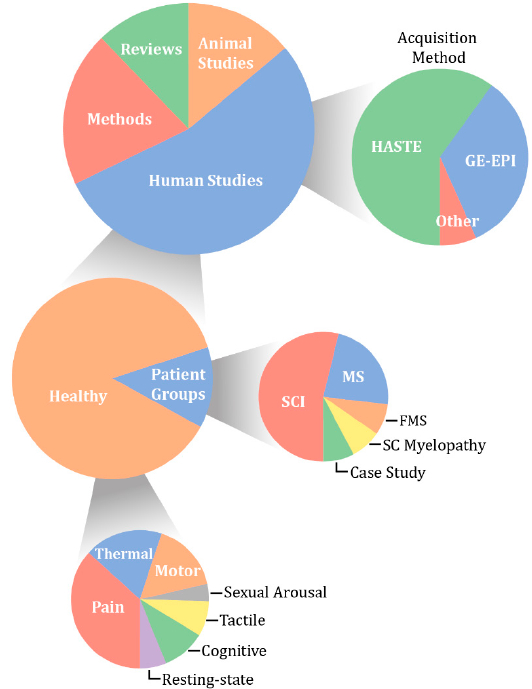
Figure 3. Chart of the distribution of spinal fMRI papers published to date, broken down by type, methods, study groups, and primary topic. HASTE—half-Fourier single-shot turbo spin echo; GE-EPI—gradient-echo with echo-planar spatial encoding; MS—multiple sclerosis; SCI—spinal cord injury; FMS—fibromyalgia syndrome.